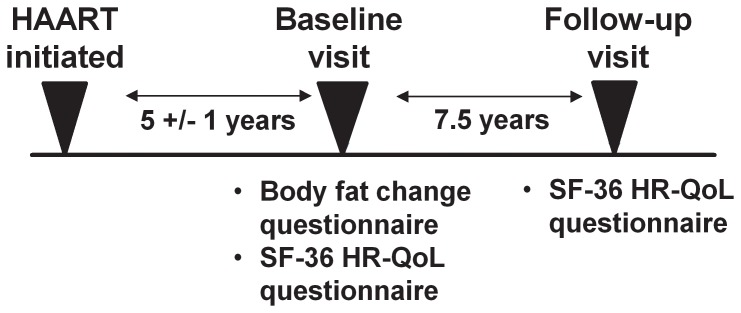
Study design indicating the relationship between the time highly active antiretroviral therapy (HAART) was initiated, the baseline visit where the initial Short Form (SF)-36 health related quality of life (HR-QoL) questionnaire was completed, and the follow-up visit when the second questionnaire was completed.